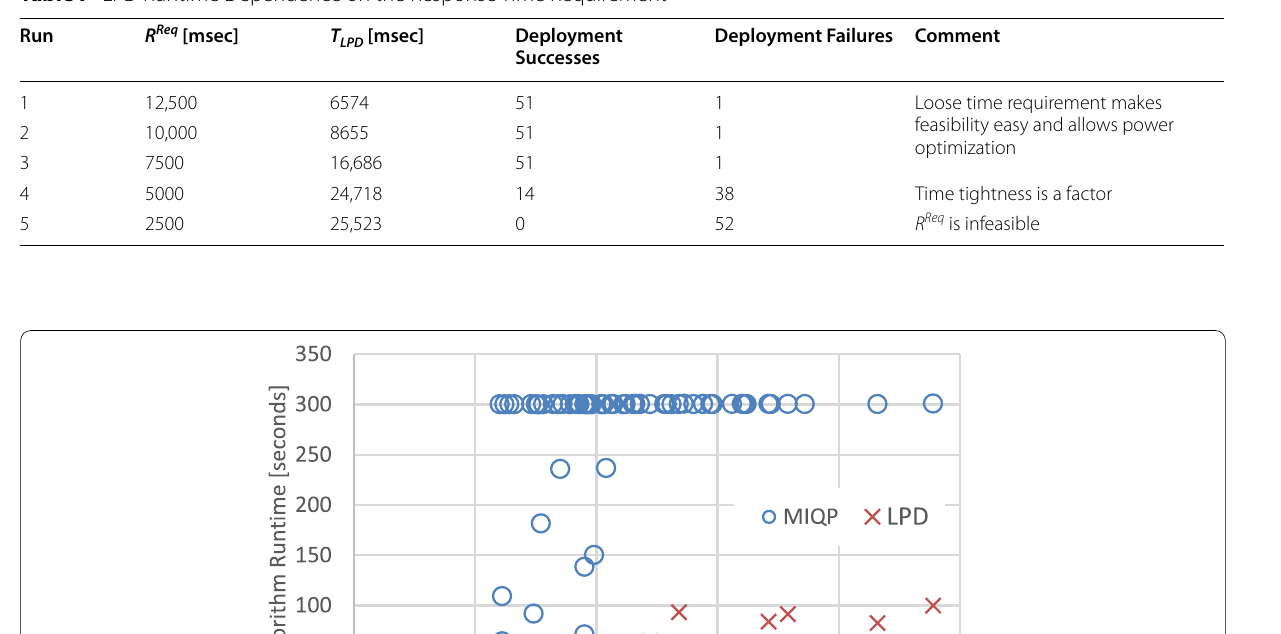
Table 7 LPD Runtime Dependence on the Response Time Requirement